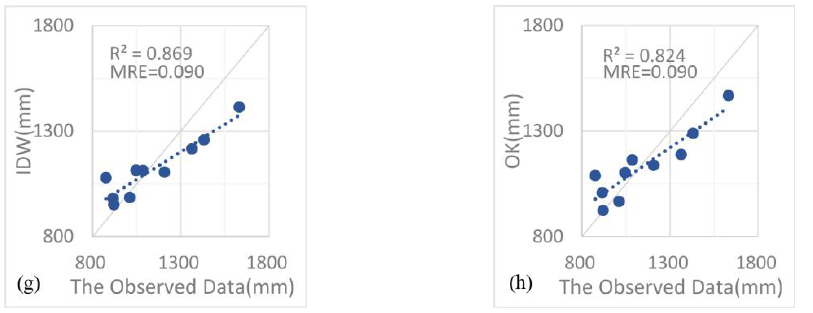
Figure 8. Scatter diagrams of test station multi-year average annual precipitation (( a ) SVM; ( b ) SVMRI; ( c ) SVMRK; ( d ) LR; ( e ) LRI; ( f ) LRK; ( g ) IDW; ( h ) OK).